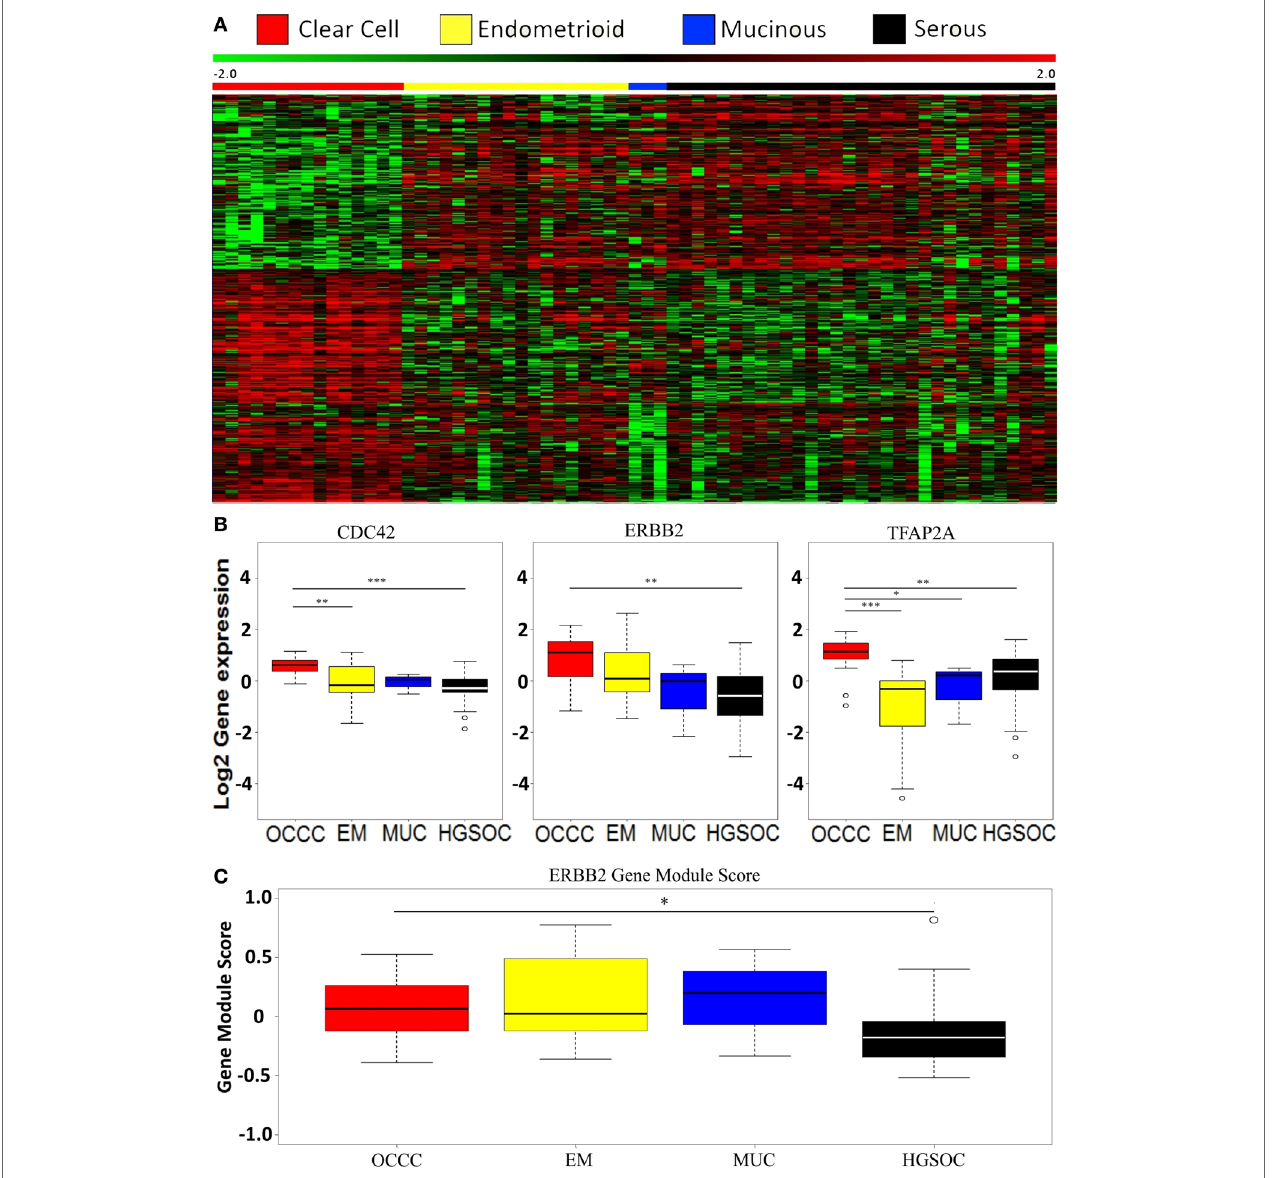
FigUre 1 | global gene expression profiles in ovarian cancer . (a) Heatmap of the 505 most significant differentially expressed genes based on a supervised multiclass significance analysis of microarrays analysis comparing the four histopathological subtypes (serous, EM, MUC, and clear cell) in cohort 1. (B) Boxplots illustrating differential expression of CDC42 , ERBB2, and TFAP2A between the histological subtypes using Dunn’s test for difference. * P < 0.05; ** P < 0.01; *** P < 0.001. (c) Boxplot illustrating ERBB2 gene module scores in the histological subtypes as defined by Desmedt et al. using Dunn’s test for difference. * P < 0.05. OCCC, ovarian clear cell carcinoma; EM, endometrioid; MUC: mucinous; HGSOC: high-grade serous ovarian